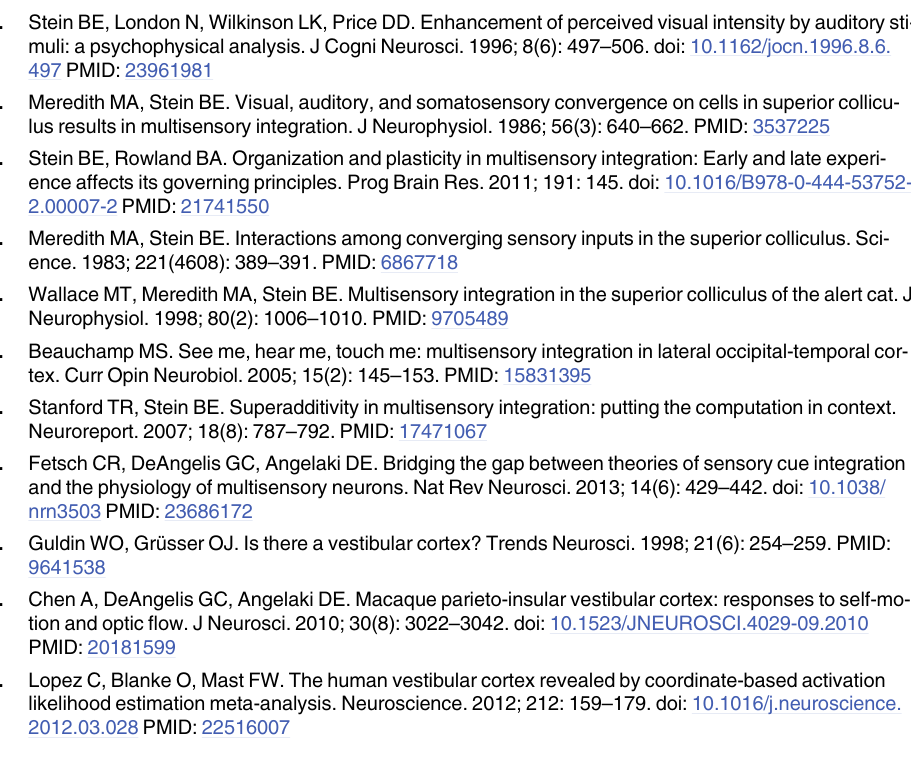
S1 Fig. EOG recordings. Examples of raw EOG